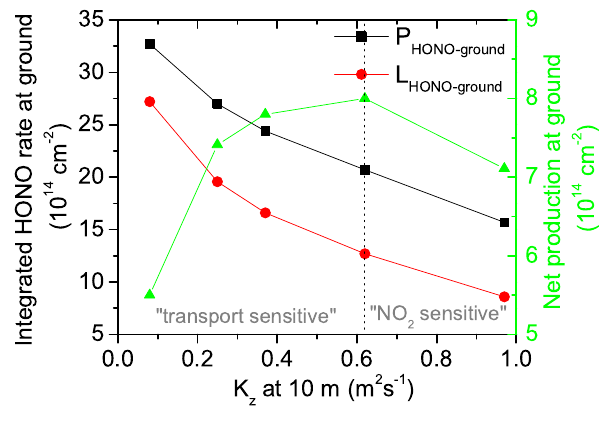
Fig. 10. Sensitivity of integrated HONO formation and loss rates throughout the night at the ground with stability. Eddy diffusivity at 10m is plotted as a measure of vertical stability.